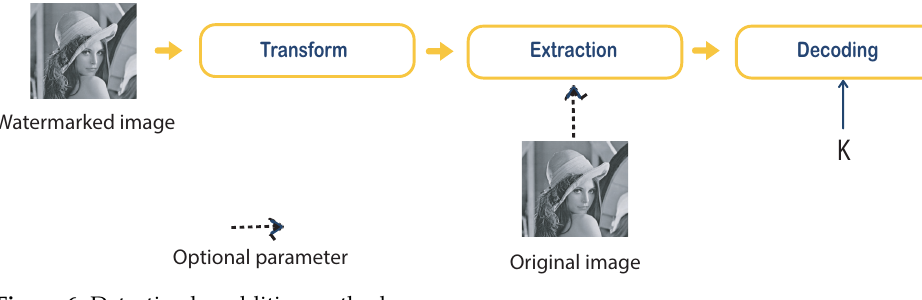
Figure 6. Detection by additive